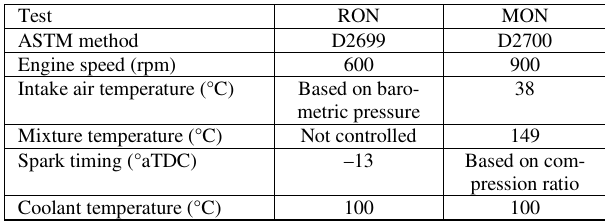
Table 1. Engine operating conditions of RON and MON tests [1, 2]